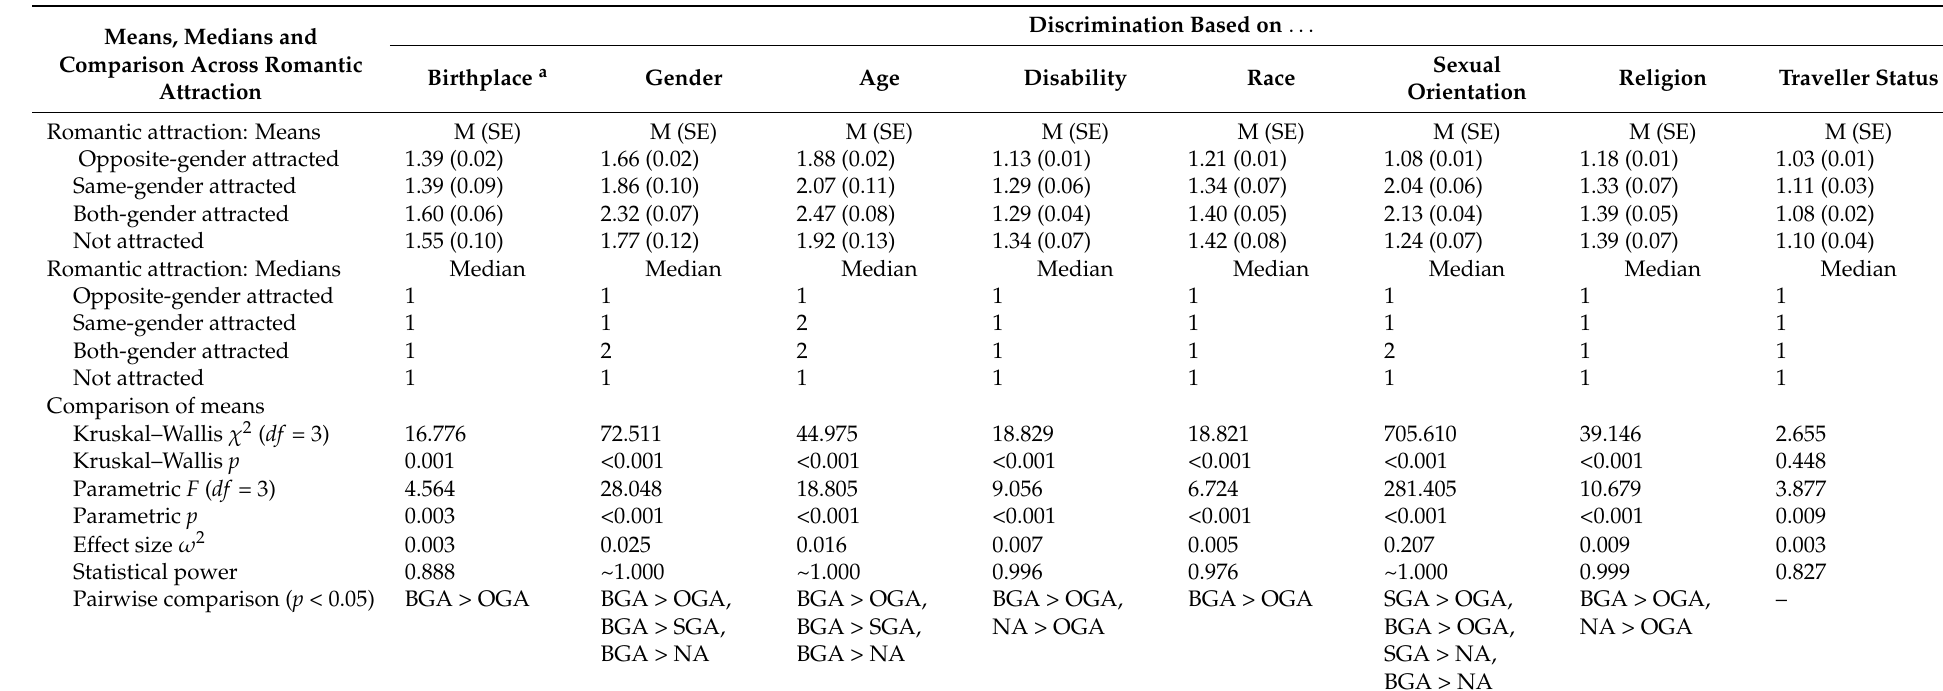
Table 4. Descriptive statistics and univariate analysis of variance of discrimination, across romantic attraction groups: opposite-gender attracted (OGA) ( n = 2845); same-gender attracted (SGA) ( n = 94); both-gender attracted (BGA) ( n = 200), and not attracted (NA) ( n =